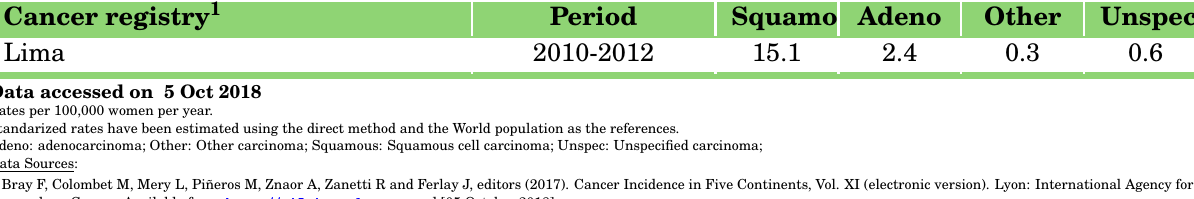
Table 4: Age-standardised incidence rates of cervical cancer in Peru by histological type and cancer